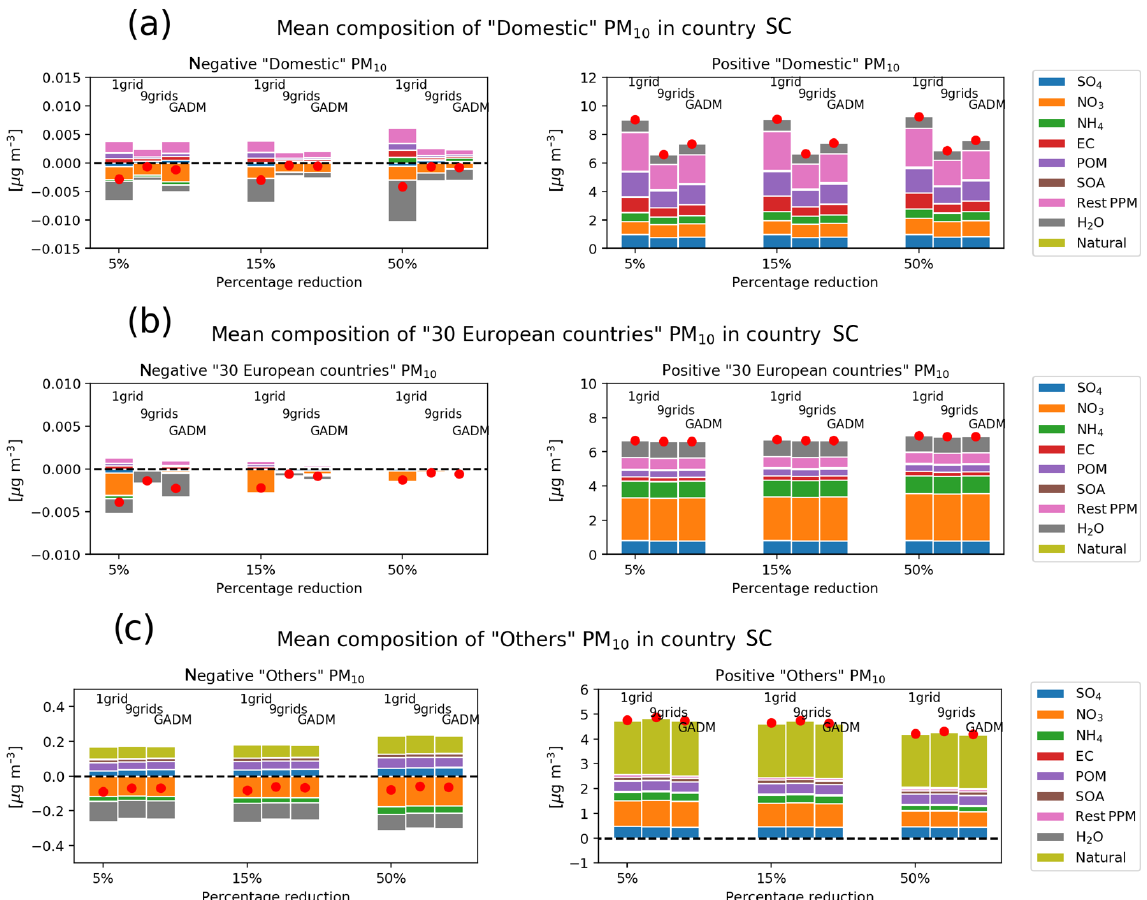
Figure 6. Mean composition of (a) Domestic, (b) 30 European countries, and (c) Others PM 10 , split into a negative concentration (left panel) and a positive concentration (right panel), calculated by the EMEP country SC over the 34 European cities and for each 4d forecast. The PM 10 composition is highlighted with the colour code. The results for the three city definitions (one grid, nine grids, and GADM) and for the percentage of reduction used in the perturbation EMEP runs (5%, 15%, and 50%) are shown. The Domestic contribution corresponds to the contribution from the domestic country to the city (e.g. from France to Paris). The label 30 European countries corresponds to the other 30 European countries used in the study. Others contains natural sources, the other countries included in the regional domain, boundary conditions, ship traffic, biogenic sources, aircraft emissions, and lightning. The red dot represents the mean PM 10